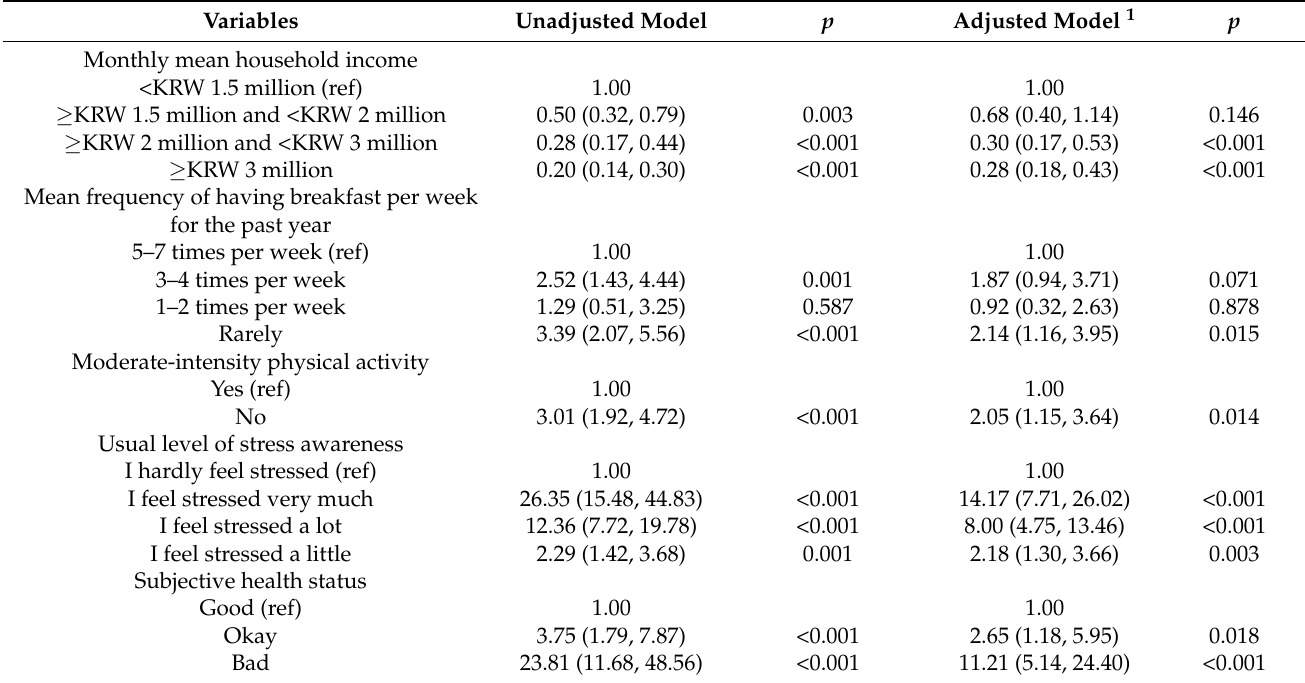
Table 3. The final model for predicting geriatric depression in the community: odds ratio (OR) and 95% confidence interval (CI). Variables Unadjusted